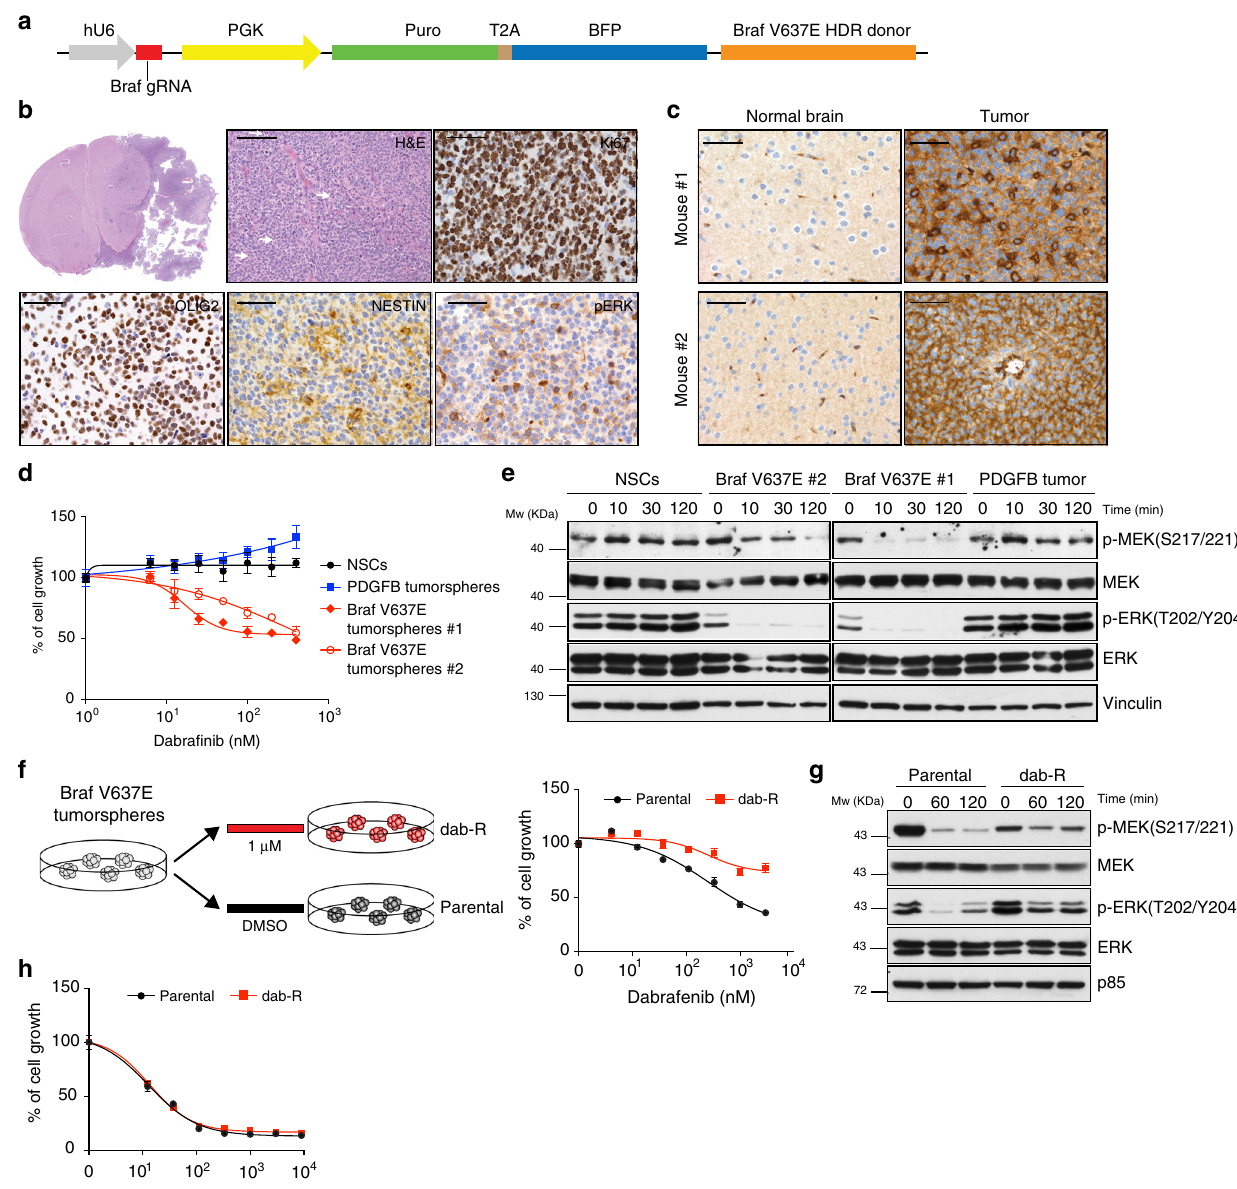
Fig. 7 Glioma formation induced by Braf V637E . a Schematic representation of the plasmid carrying the Braf gRNA and the Braf V637E Homology-Directed- Repair (HDR) donor. b H&E and IHCs using the indicated antibodies. White arrows point to mitotic fi gures. Scale bars: H&E 100 μ m; IHCs 50 μ m. c IHCs using an anti-BRAF V600E antibody on two Braf V637E mutant tumors. Contralateral normal brain was used as a negative control. d Cell proliferation assay performed on p53-null TVA-Cas9 NSCs and Braf V637E tumorspheres exposed for 96 h to increasing doses of dabrafenib. e Western blot analysis using the speci fi ed antibodies on p53-null TVA-Cas9 NSCs and Braf V637E tumorspheres grown overnight in absence of growth factors and then treated with dabrafenib (200 nM) for the indicated time. f Left panel: schematic representation of the generation of dabrafenib-resistant cell line (dab-R). Right panel: cell proliferation assay performed on parental Braf V637E and dab-R tumorspheres exposed for 96 h to increasing doses of dabrafenib. g Western blot analysis using the speci fi ed antibodies on parental Braf V637E and dab-R tumorspheres grown overnight in absence of growth factors and then treated with dabrafenib (200 nM) for the indicated time points. h Cell proliferation assay performed on parental Braf V637E and dab-R tumorspheres exposed for 96 h to increasing doses of